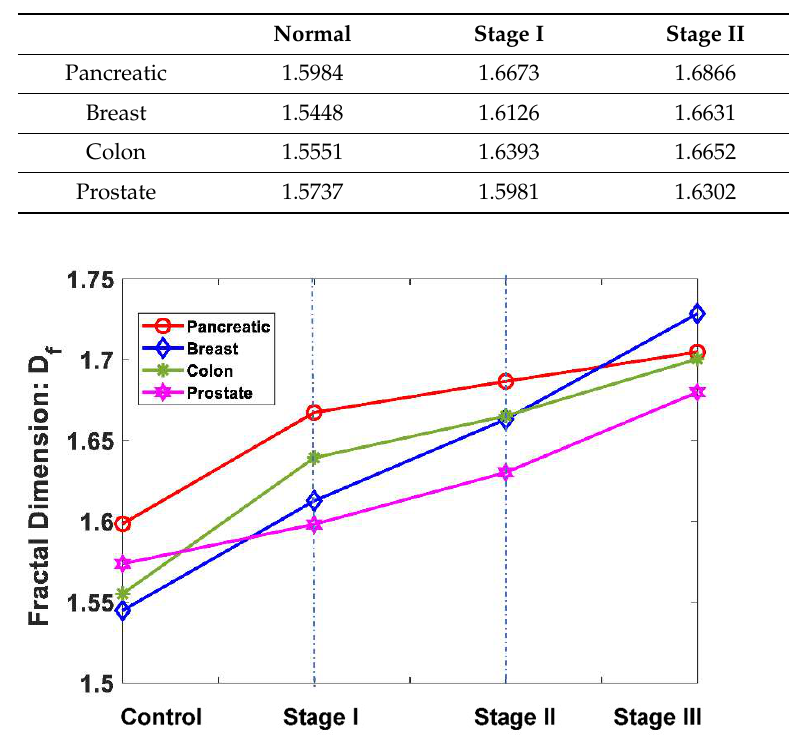
Table 1. The mean values of the fractal dimension of different cancer for different stages.